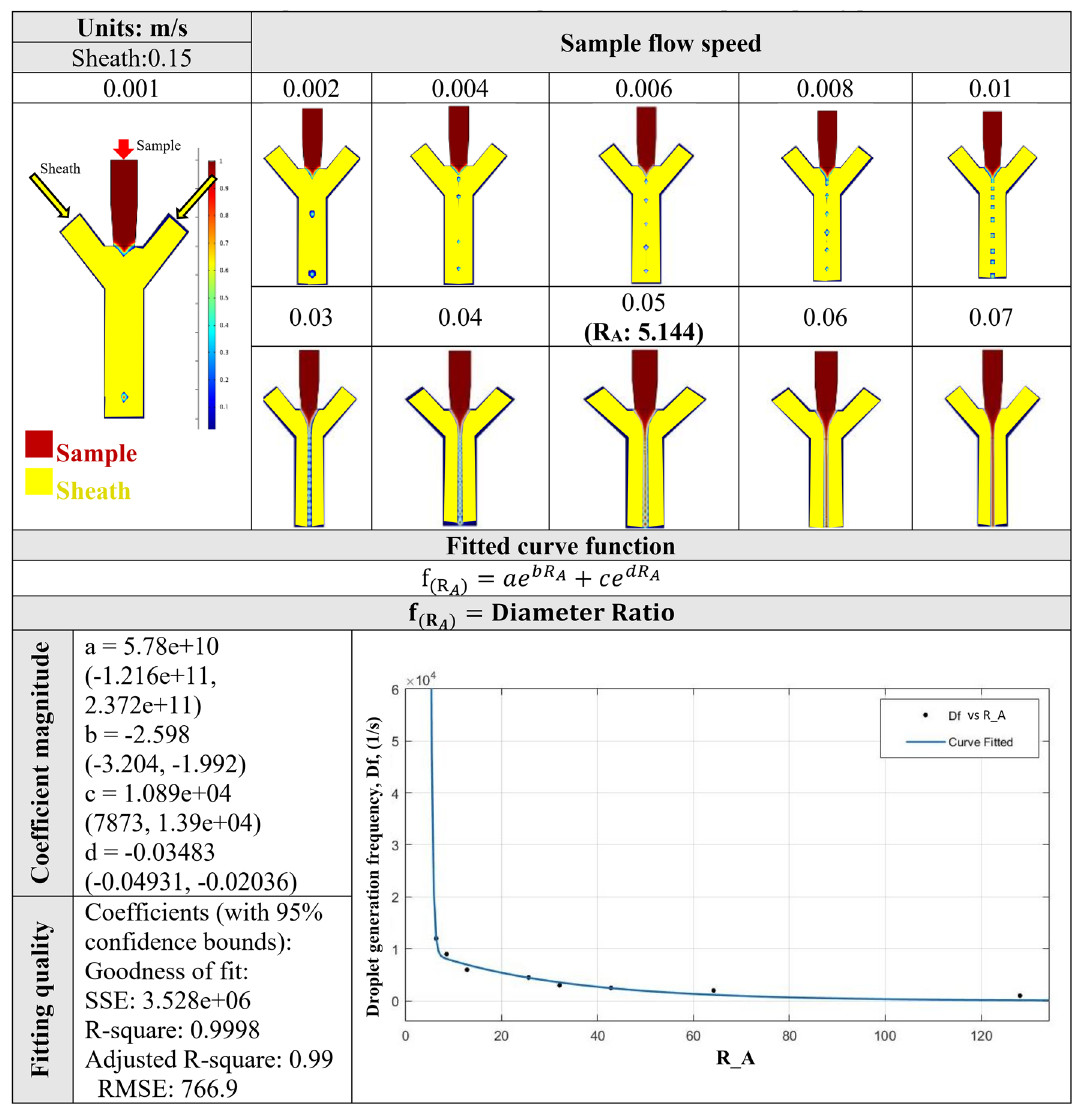
Figure 7. The droplet formation of calcium alginate and microdroplet frequency